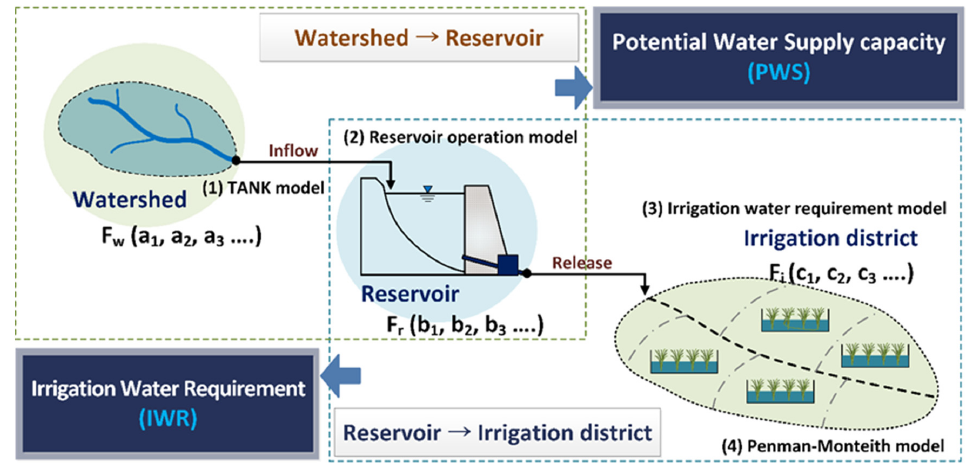
Figure 3. Elements of the water resources balance model for agricultural reservoirs [48].